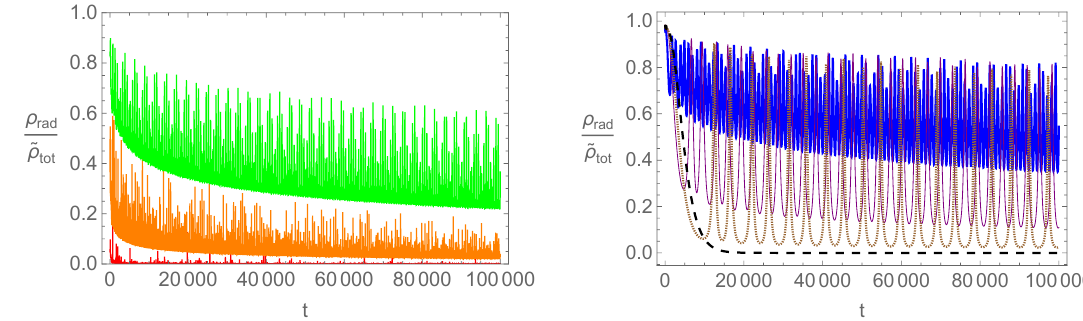
Figure 10. Time evolution of the ratio ρ rad / ˜ ρ tot for various values of σ ∗ . The parameter is chosen from the bottom to the top as σ = 6 . 0 (red), 8.3 (orange), 10.6 (green), which correspond to ∗ b vac = 10 , 31.7, 100 in the left plot, and σ ∗ = 12 . 9 (blue), 15.2 (purple thin), 16.0 (brown fine dashed), 16.8 (black coarse dashed), which correspond to b = 316 , 1000 , 1490 , 2223 in the right vac plot, respectively. The other parameters are chosen as (4.7).